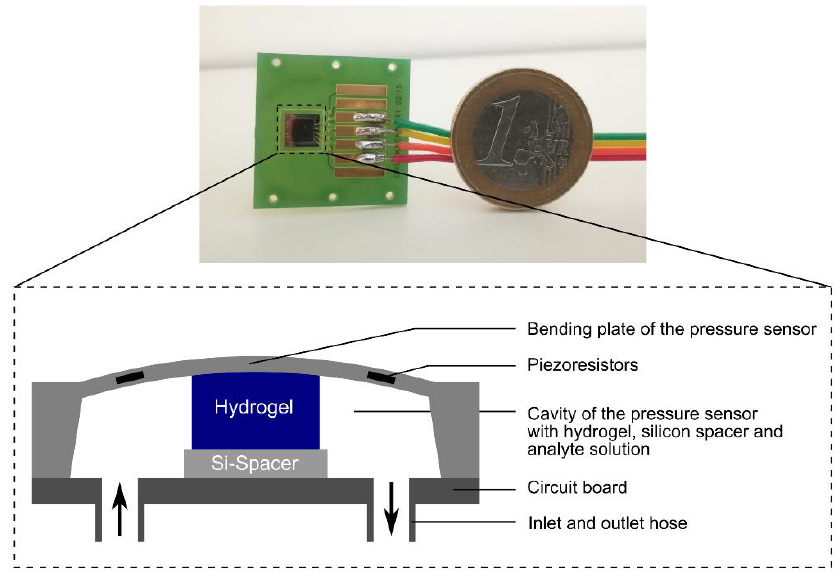
Figure 2. Set-up of a hydrogel-based piezoresistive ethanol sensor: The swelling pressure of the gel leads to a deformation of the bending plate and the piezoresistors. The change in resistance due to the piezoresistive effect will be transformed into an output voltage via a Wheatstone bridge circuit. The figure was modified according to [10].